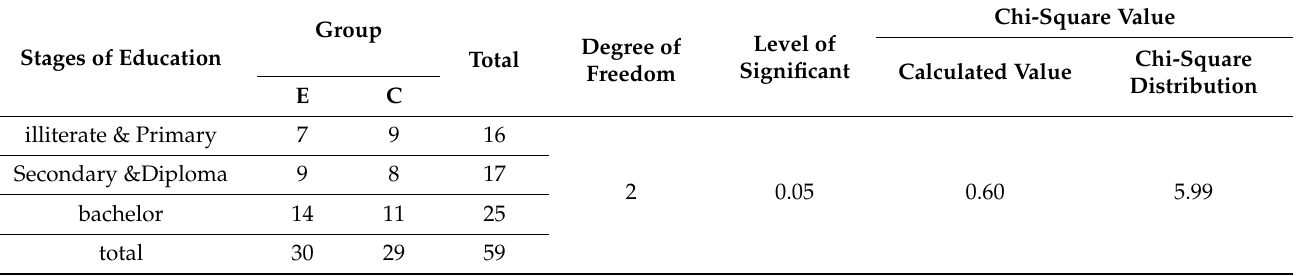
Table 5. Frequency And Chi-Square Value For The Fathers’ Academic Attainment Of Both Groups.